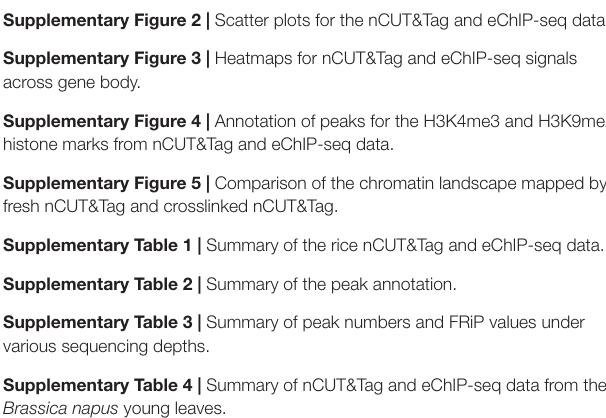
Supplementary Figure 1 | Correlation heatmaps for the nCUT&Tag and eChIP-seq data. Supplementary Figure 2 | Scatter plots for the nCUT&Tag and eChIP-seq data. Supplementary Figure 3 | Heatmaps for nCUT&Tag and eChIP-seq signals across gene body. Supplementary Figure 4 | Annotation of peaks for the H3K4me3 and H3K9me2 histone marks from nCUT&Tag and eChIP-seq data. Supplementary Figure 5 | Comparison of the chromatin landscape mapped by fresh nCUT&Tag and crosslinked nCUT&Tag. Supplementary Table 1 | Summary of the rice nCUT&Tag and eChIP-seq data. Supplementary Table 2 | Summary of the peak annotation. Supplementary Table 3 | Summary of peak numbers and FRiP values under various sequencing depths. Supplementary Table 4 | Summary of nCUT&Tag and eChIP-seq data from the Brassica napus young